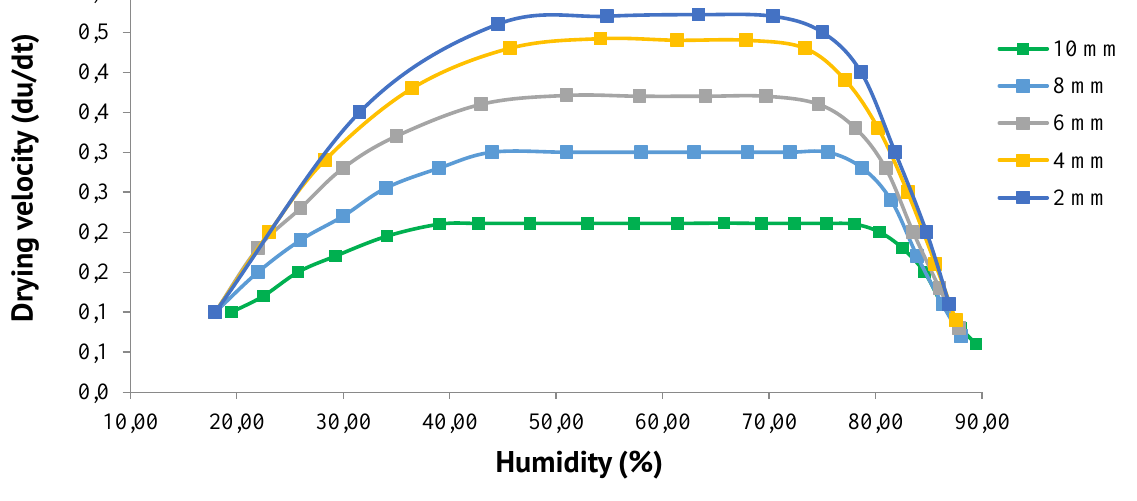
Figure 6. SPRINGCREST peaches different slices thickness drying velocity curves (Thermal agent velocity 2.0 m . s -1 , thermal agent relative humidity 65.0%, thermal agent temperature 60°C).